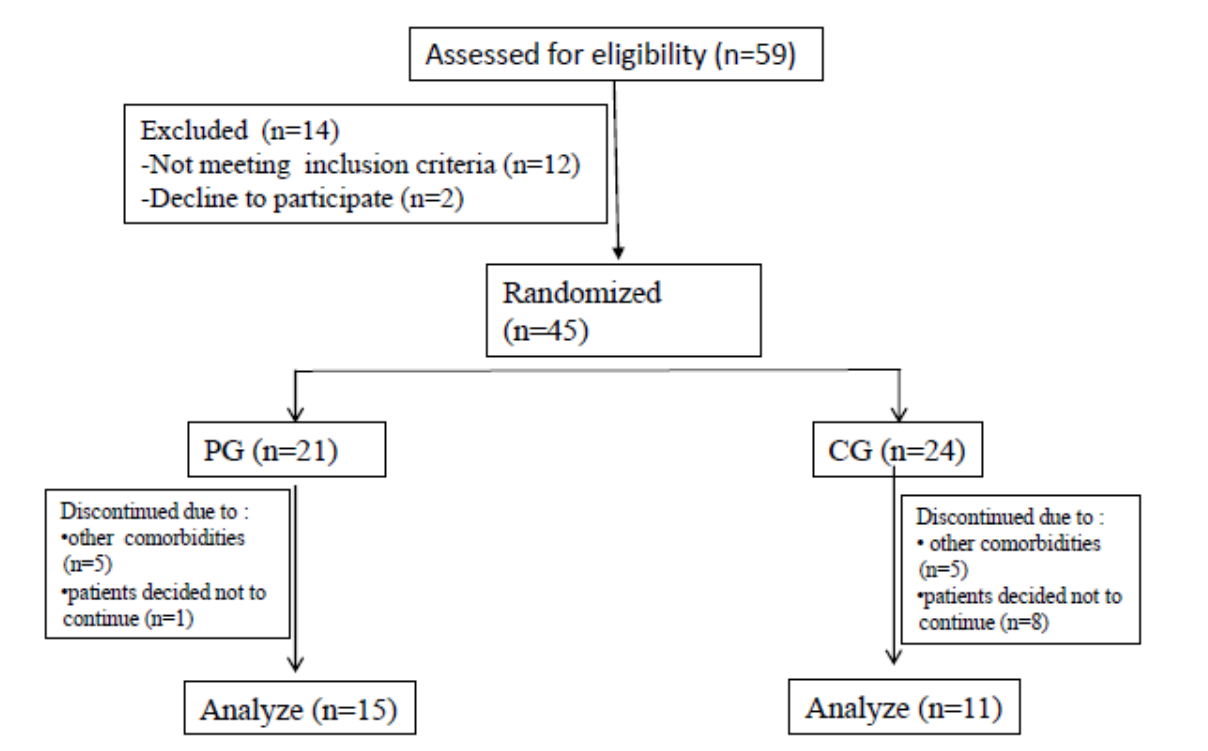
Figure 1. Flow chart of subject participation and analysis.